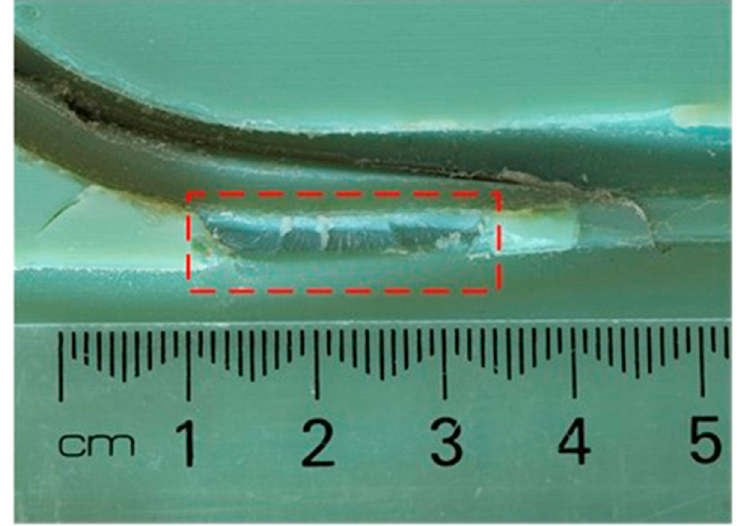
Figure 10. Shear failure of the runner wall (boxed area), due to high injection pressure. See Figure 3 for the location on the tool.